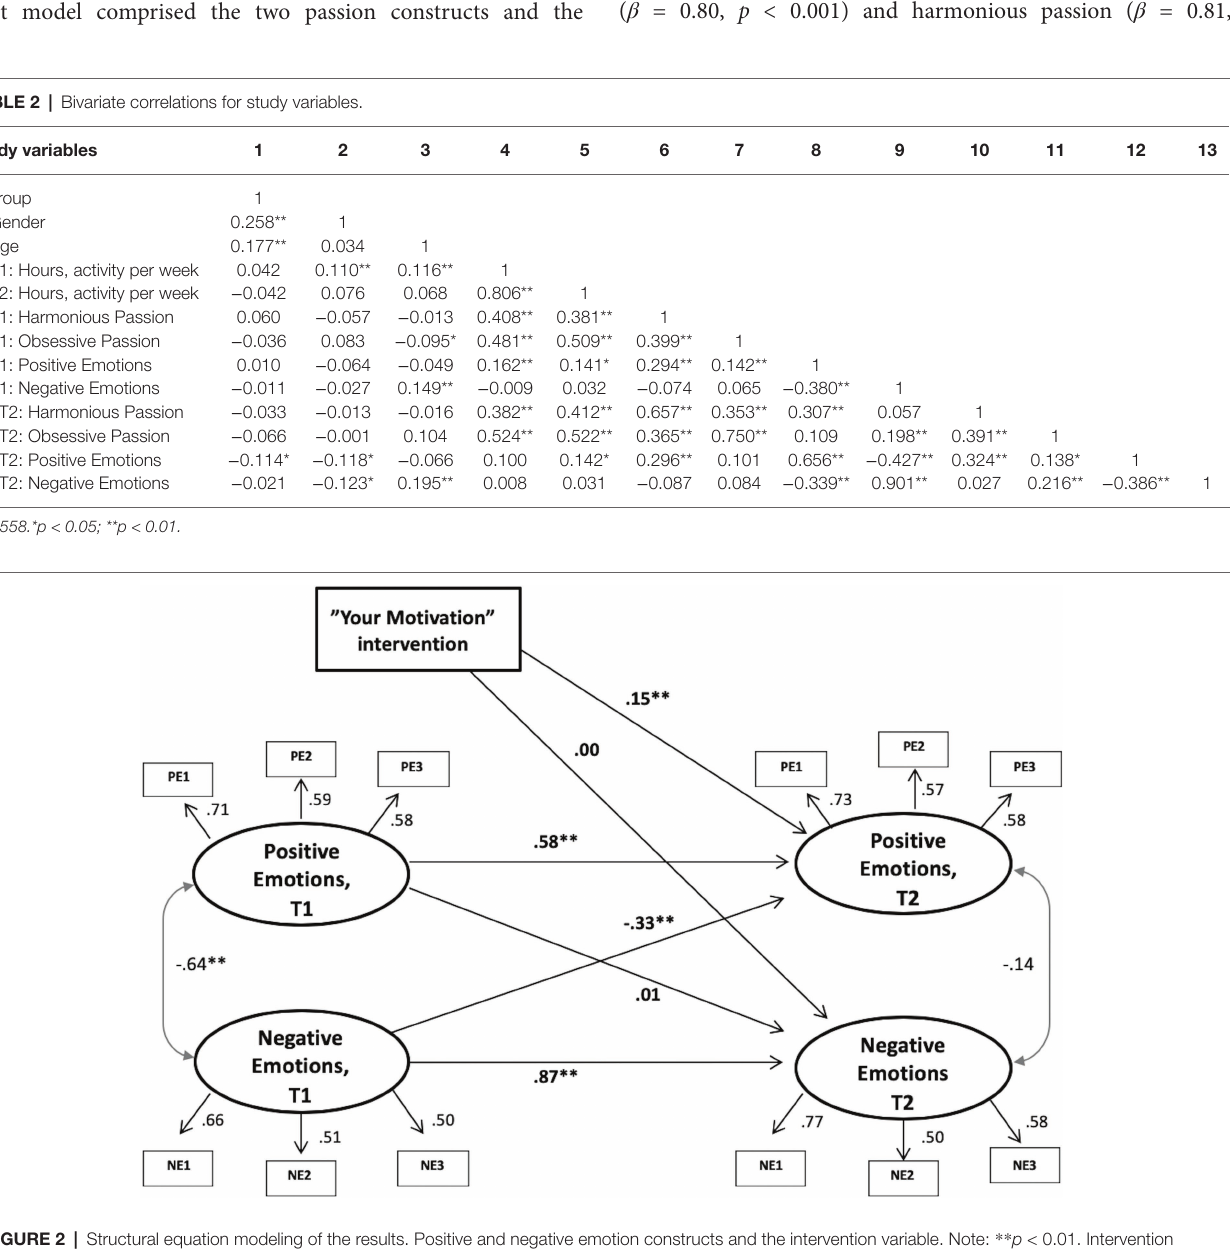
FIGURE 2 | Structural equation modeling of the results. Positive and negative emotion constructs and the intervention variable. Note: ** p < 0.01. Intervention variable: Intervention group = 1, Control group =